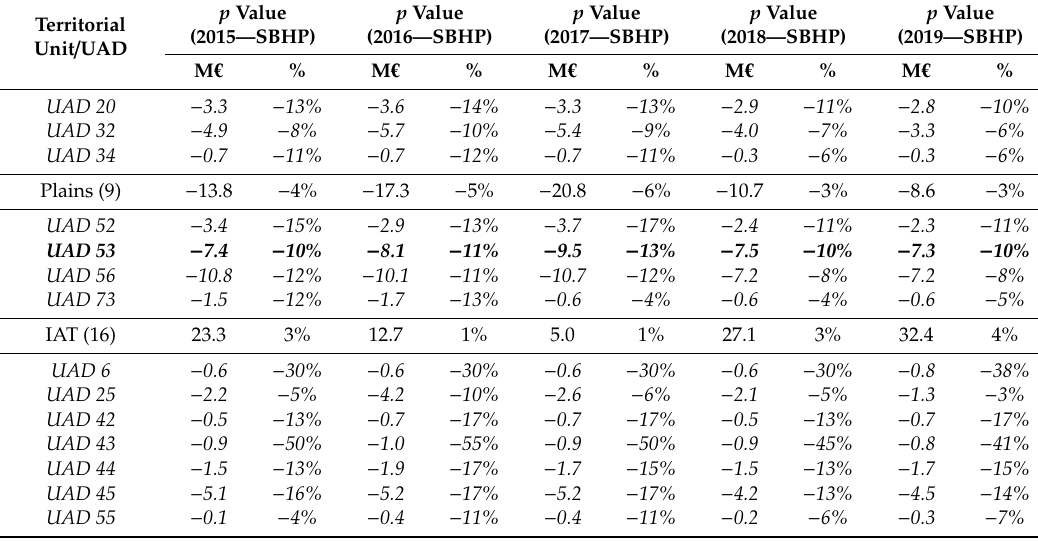
Table 15. Variation in the production value in the years analysed with respect to the value obtained with the average water applied in the SBHP, examples of some UADs with a decrease in the period analysed. Source: SBHP. Own